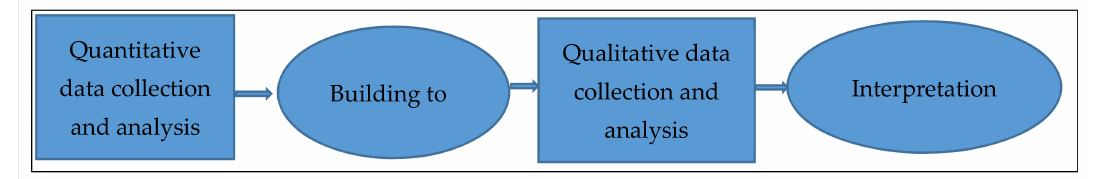
Figure 3. An outline of the explanatory sequential design undertaken in this